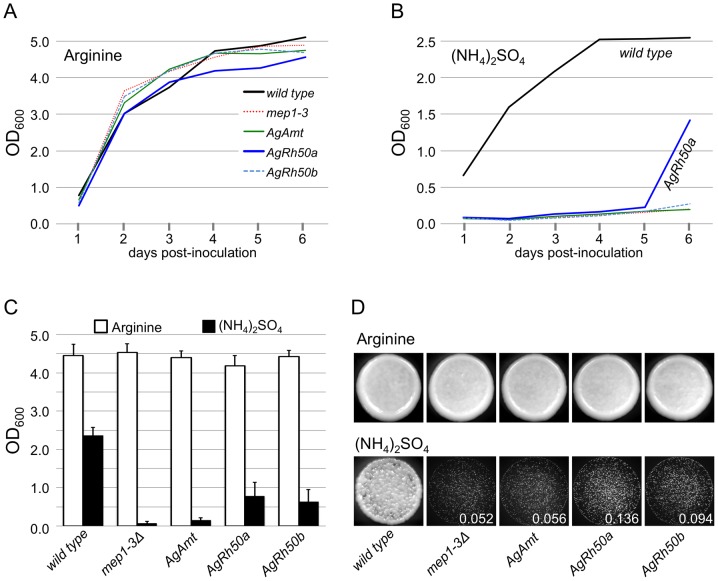

AgRh50 Complements a Yeast Ammonium Transporter Mutant.Representative growth curve of wild type yeast and mep1-3Δ triple mutant transformants in minimal medium supplemented with 1 mM Arginine (A) or 1 mM ammonium sulfate (B) as the sole nitrogen source. (C) Histogram plot of mean optical densities for yeast transformants grown in minimal medium supplemented with 1 mM Arginine (white bards) or 1 mM ammonium sulfate (black bars). Error bars are SEM; n = 4. (D) Growth of yeast transformants spotted onto solid minimal medium with indicated supplements as above. Circles are 10 ul spots of ∼1000–2000 cells each, showing confluent growth on 1 mM Arginine (top panels) and reduced growth on 1 mM ammonium sulfate (bottom panels). Mean colony area (mm2) indicated in lower corner of bottom panes.